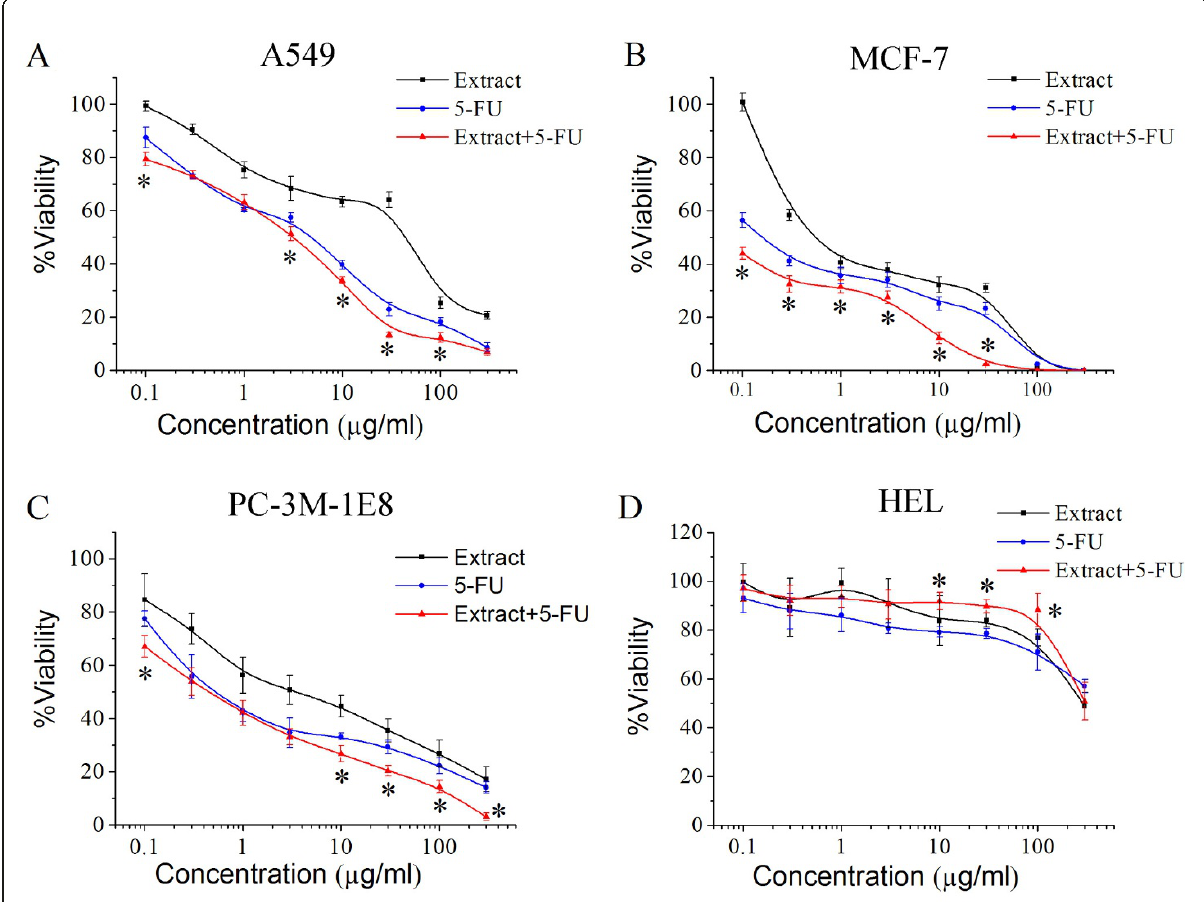
Figure 5 Effect of TC extract and 5-FU on growth of human cancer cell lines and normal cells . Human lung cancer cell line A549 (A), human breast cancer cell line MCF-7 (B), human prostate cancer cell line PC-3M-1E8 (C), and human embryo lung cell line HEL (D) were exposed to graded concentrations of TC extract (0.1-300 μ g/ml), 5-FU (0.1-300 μ g/ml), or the combination for 72 h. The proportion of live cells was quantified by ATP assay. Each point represents the mean ± S.D. (n = 5), and asterisks indicate significance at P < 0.05, compared with 5-FU